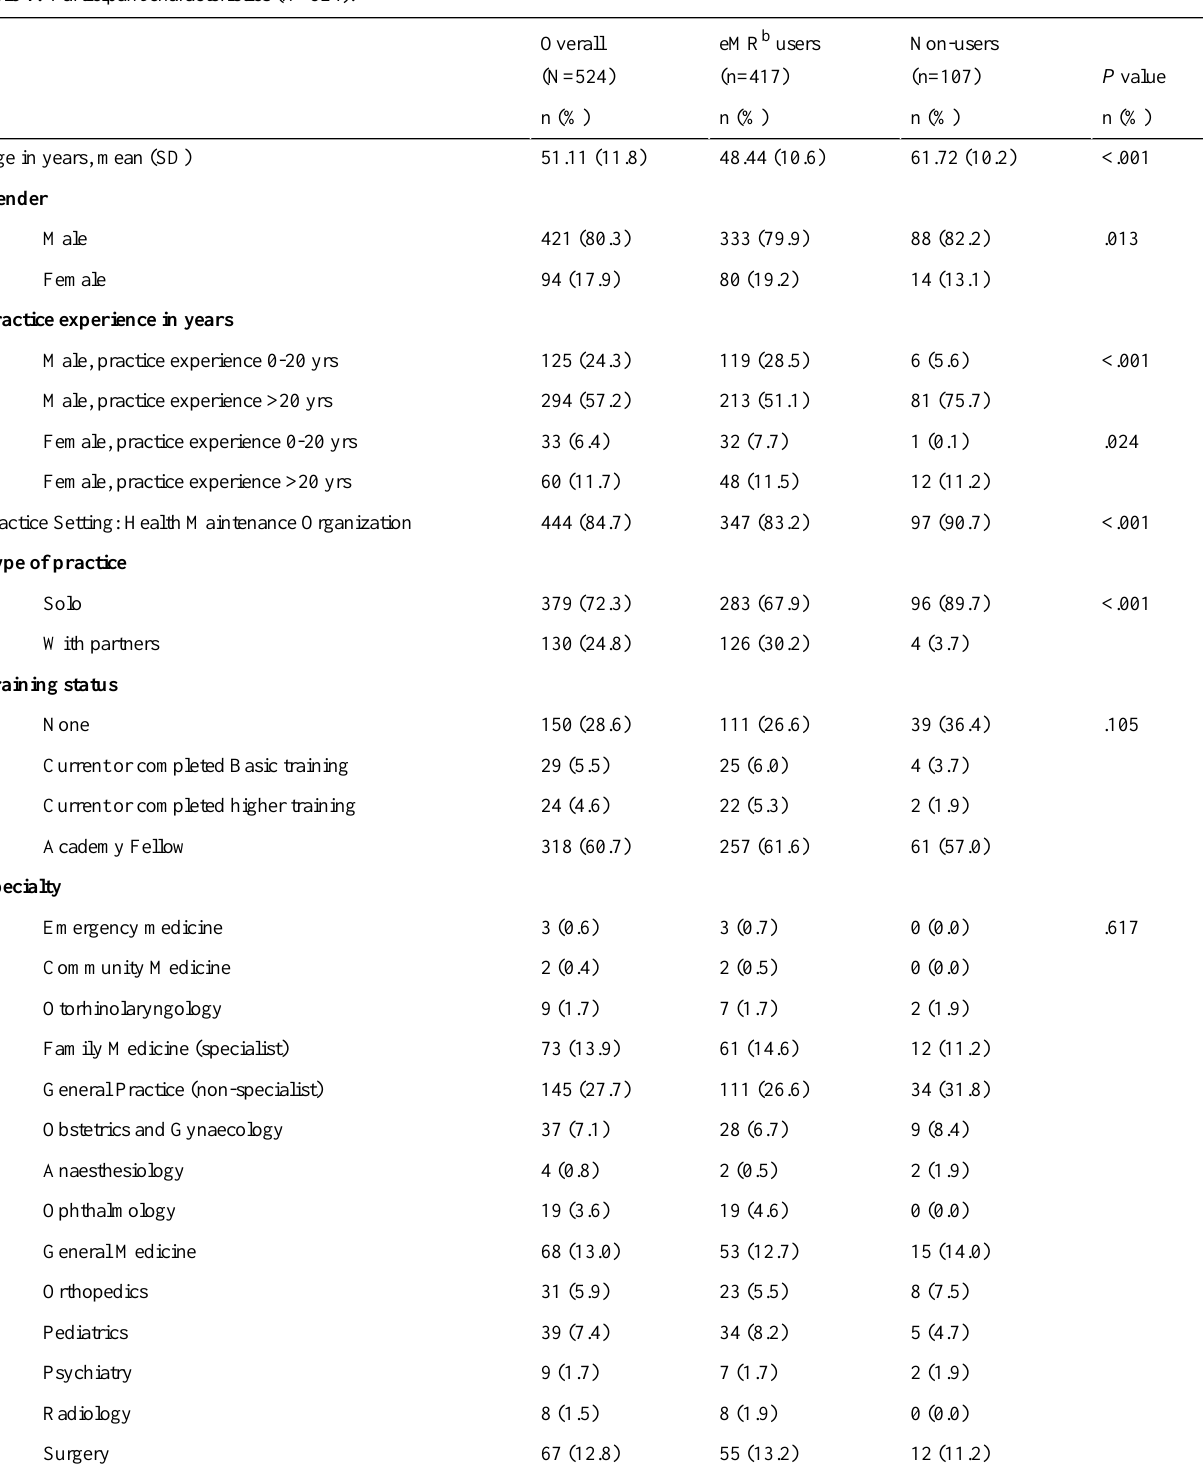
Table 1. Participant characteristics (N=524).